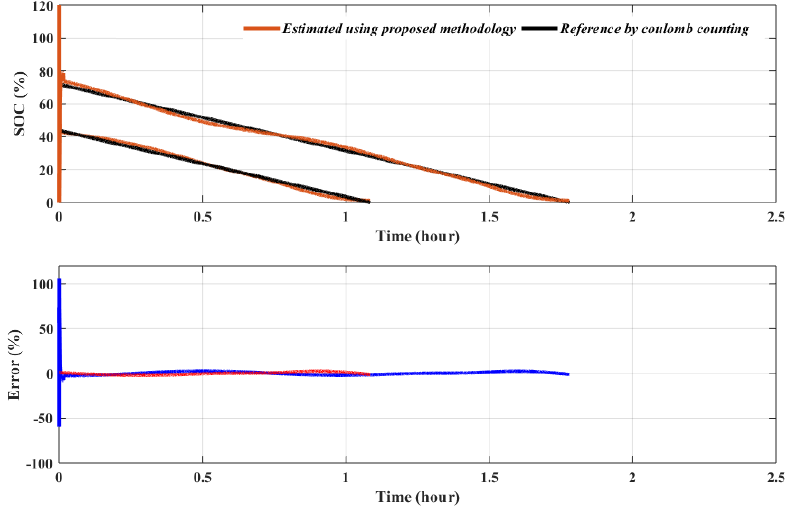
Figure 8. Terminal voltage, current, estimated SOC and reference SOC profiles for hybrid pulse experiment.